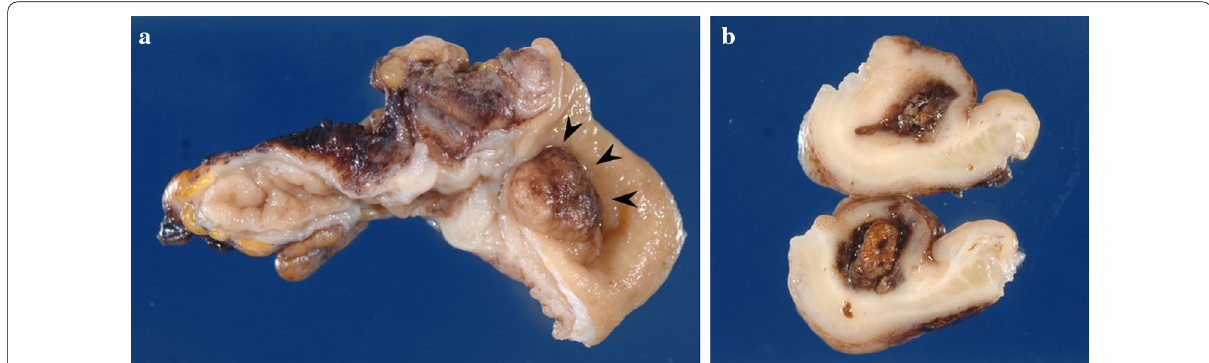
Fig. 3 Macroscopic findings. a A mass similar to the submucosal tumor (black arrowhead) was detected near the appendix root. b A fecalith measuring 12 mm was detected in the submucosal layer